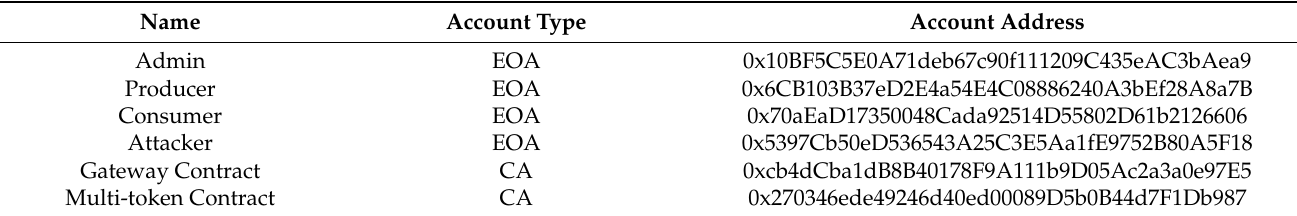
Table 5. List of EOA, CA used in the